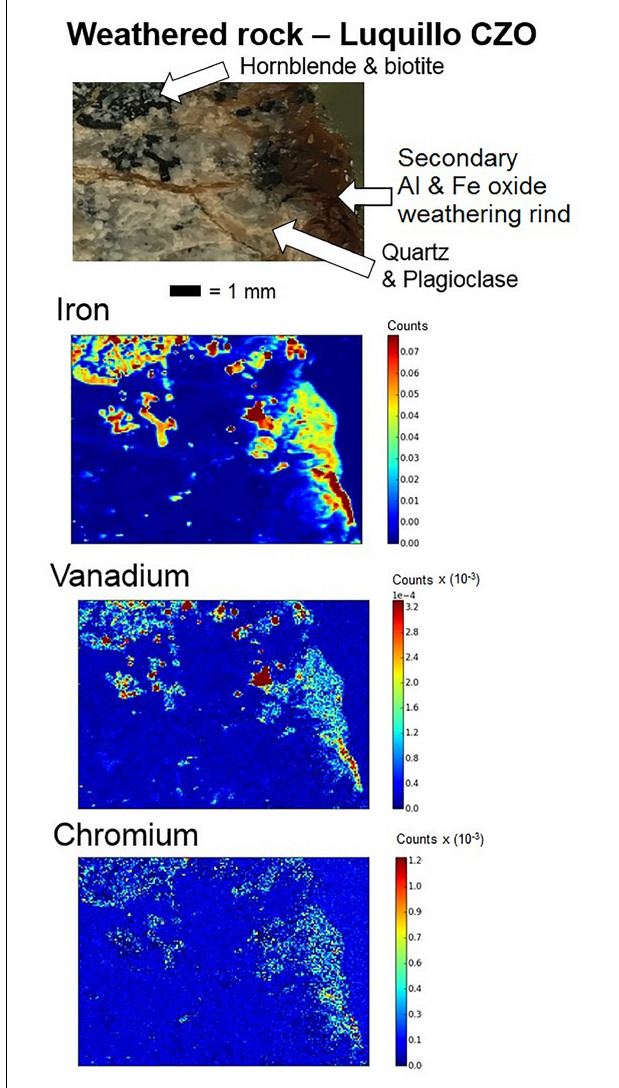
FIGURE 5 | Images of intact regolith from Luquillo CZO at 1.6 m depth and µ -XRF maps of Fe, V, and Cr using Synchrotron radiation at the Cornell High Energy Synchrotron Source (CHESS) Beamline F3. Molybdenum was not